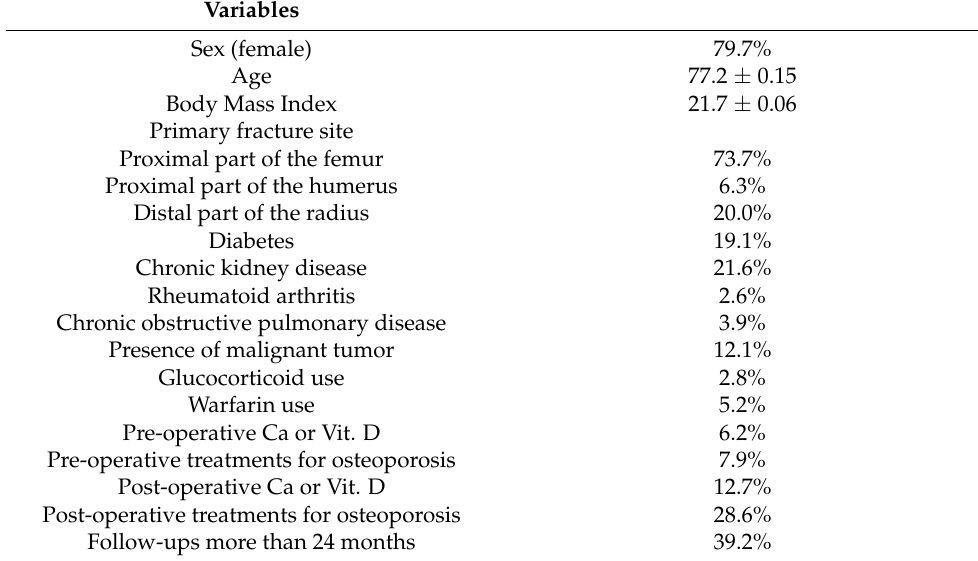
Table 1. Demographic data of the enrolled patients.